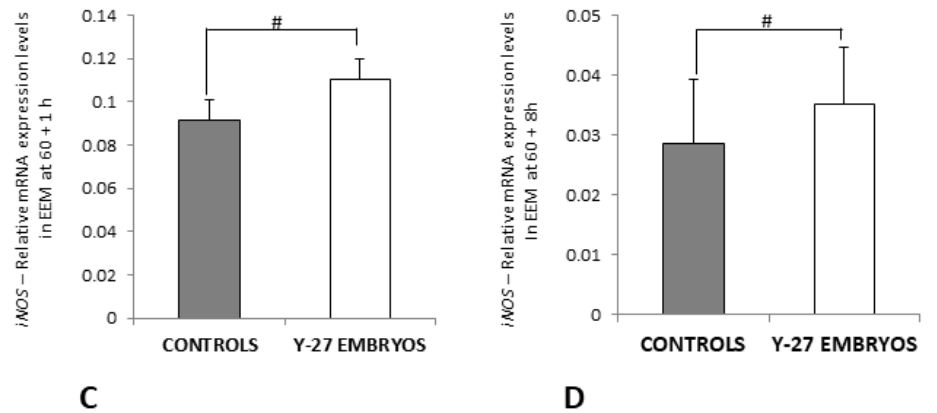
Figure 11. The relative mRNA expression levels of iNOS in embryos ( A,B ) and EEM ( C,D ) of the control group and Y-27632 (500 µM) treatment group at 60 + 1 h and 60 + 8 h. The expression levels of iNOS at 60 + 1 h were significantly higher in the treatment group when compared to controls ( C , * p < 0.05). The expression levels of iNOS at 60 + 8 h were significantly lower in the treatment group when compared to controls ( D , ** p = 0.004). The expression levels of iNOS were not different between membranes of the control and treatment group at 60 + 1 h and 60 + 8 h ( C , D , # p > 0.05). The vertical bars represent the SD. y-axis : Relative mRNA Expression Levels.